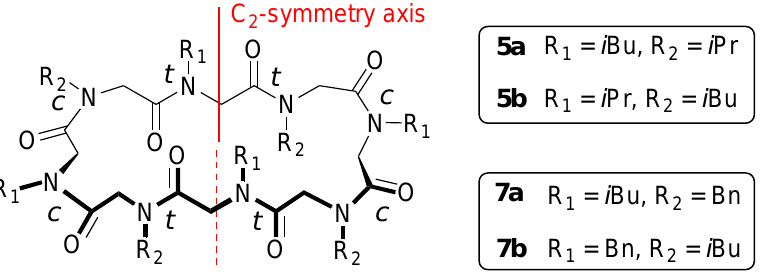
Figure 3. Schematic structure of the possible conformational diastereoisomers for cyclic peptoids 5 and 7 . C 2 -symmetric ccttcctt -conformational diastereoisomers 5a/b and 7a/b were modelled by DFT